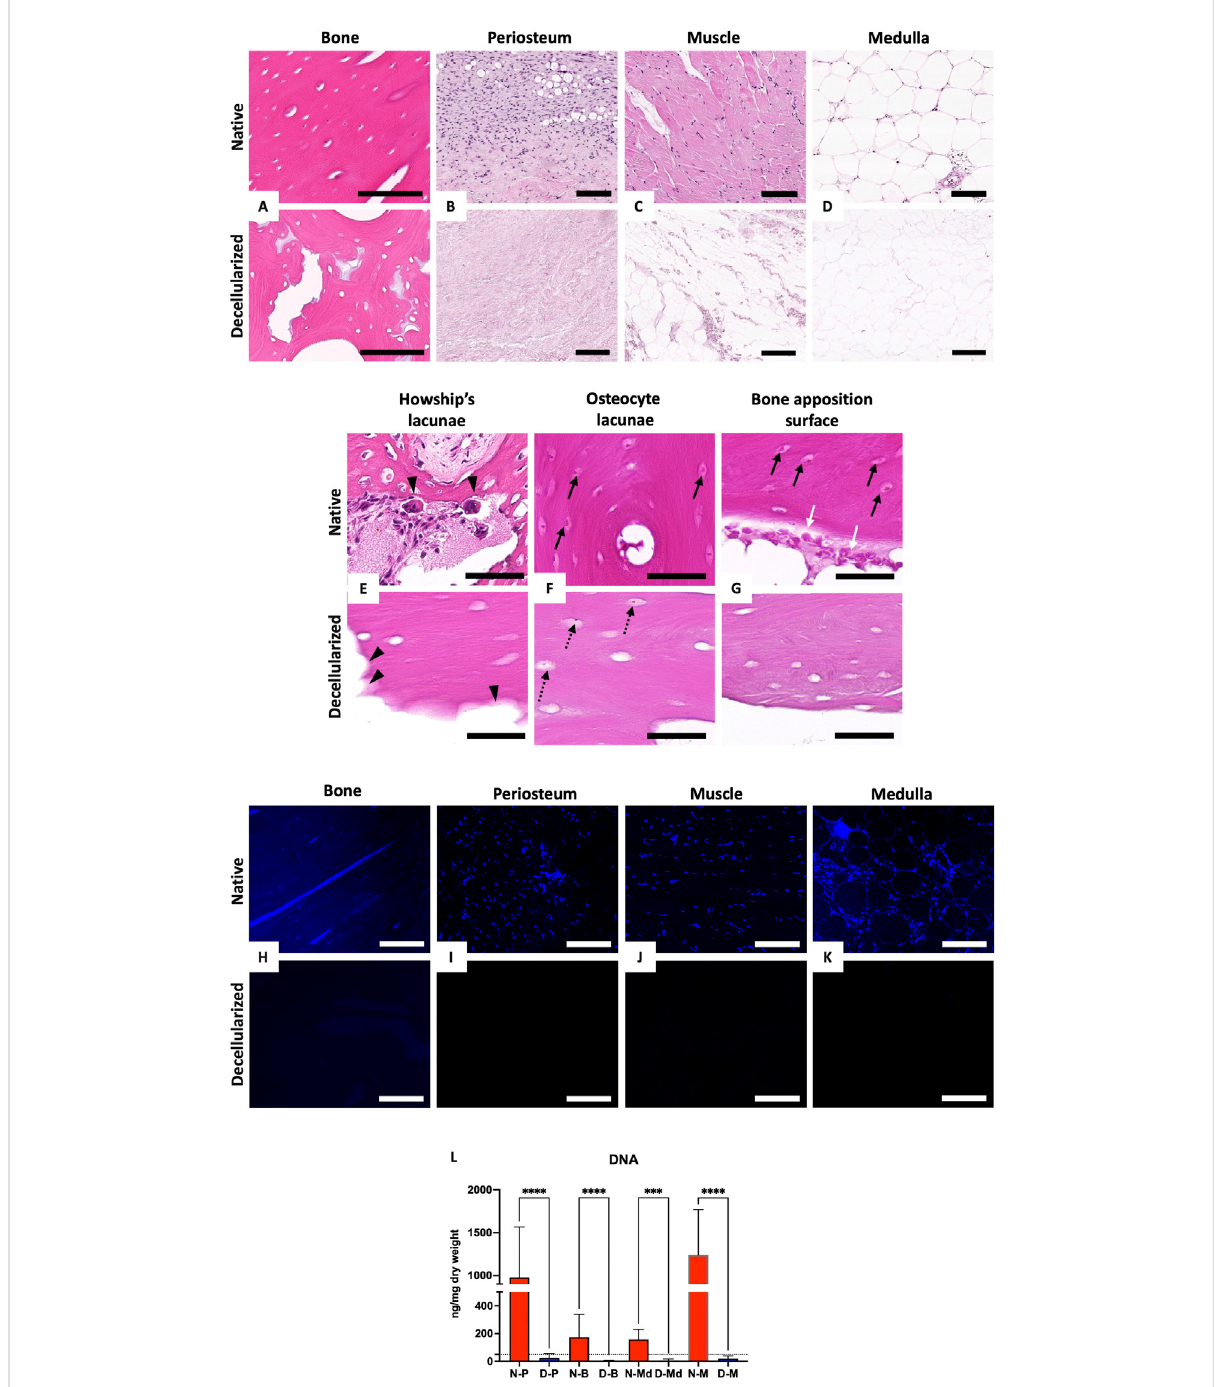
FIGURE 2 Evaluation of decellularization ef fi ciency. (A – G) : H&E histological staining of native (top) and decellularized (bottom) cortical bone (A) , periosteum (B) , muscle (C) and medulla (D) . Magni fi cation of native (top) and decellularized (bottom) bone resorption lacunae (Howship ’ s lacunae) (E), osteocyte lacunae (F) and bone apposition surface (G) ; head arrows = Howship ’ s lacuna, white arrows = osteoblasts, black arrows = native osteocytes, dotted arrows = residual cells. Scale bar for (A) = 100 μ m, (B – D) = 200 µm and for (E – G) = 50 µm. (H – K) : DAPI staining of native (top) and decellularized (bottom) cortical bone (G) , periosteum (H) , muscle (I) and medulla (J) . All scale bars = 100 µm. (L) : DNA quanti fi cation in native(N-,red)anddecellularized(D-,blue)muscle(M),corticalbone(B),periosteum(P),andmedulla(Md)(n=5each,meanvaluesexpressedinng/ mg dry weight ± SD; *** p < 0.001, **** p <